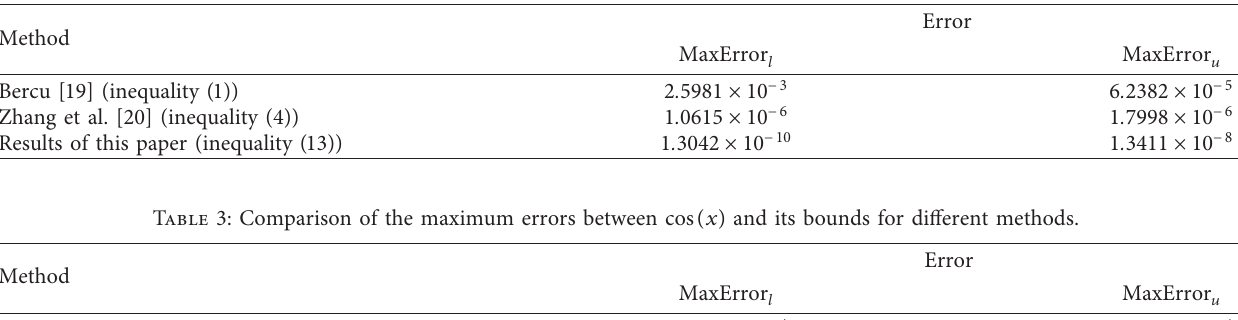
Table 2: Comparison of the maximum errors between sinc ( x ) and its bounds for different methods.